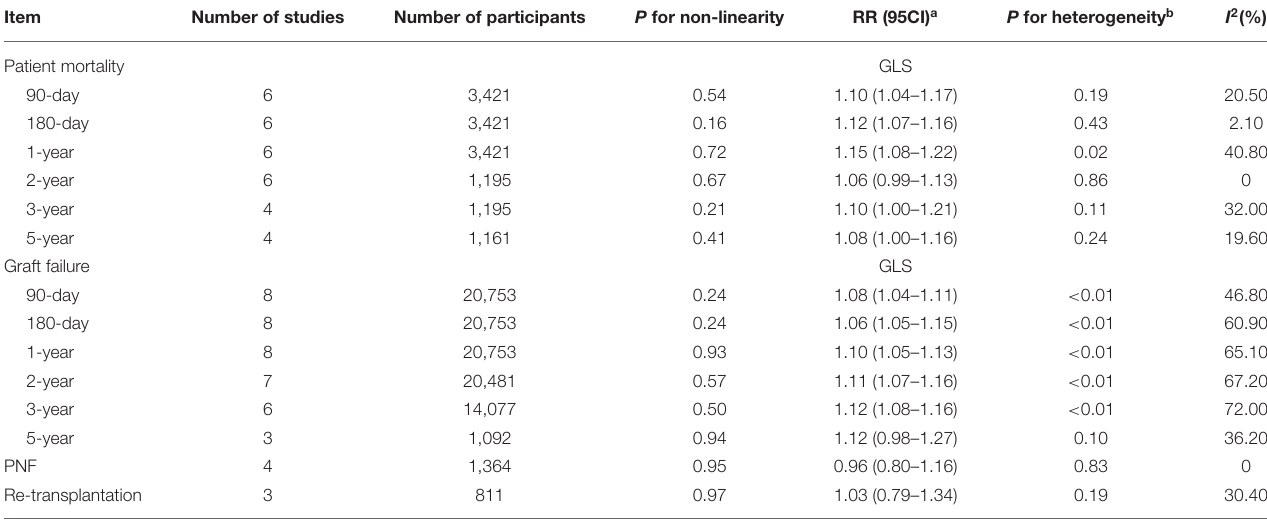
TABLE 3 | Continuous risk of donor age on post-transplant outcomes in linear